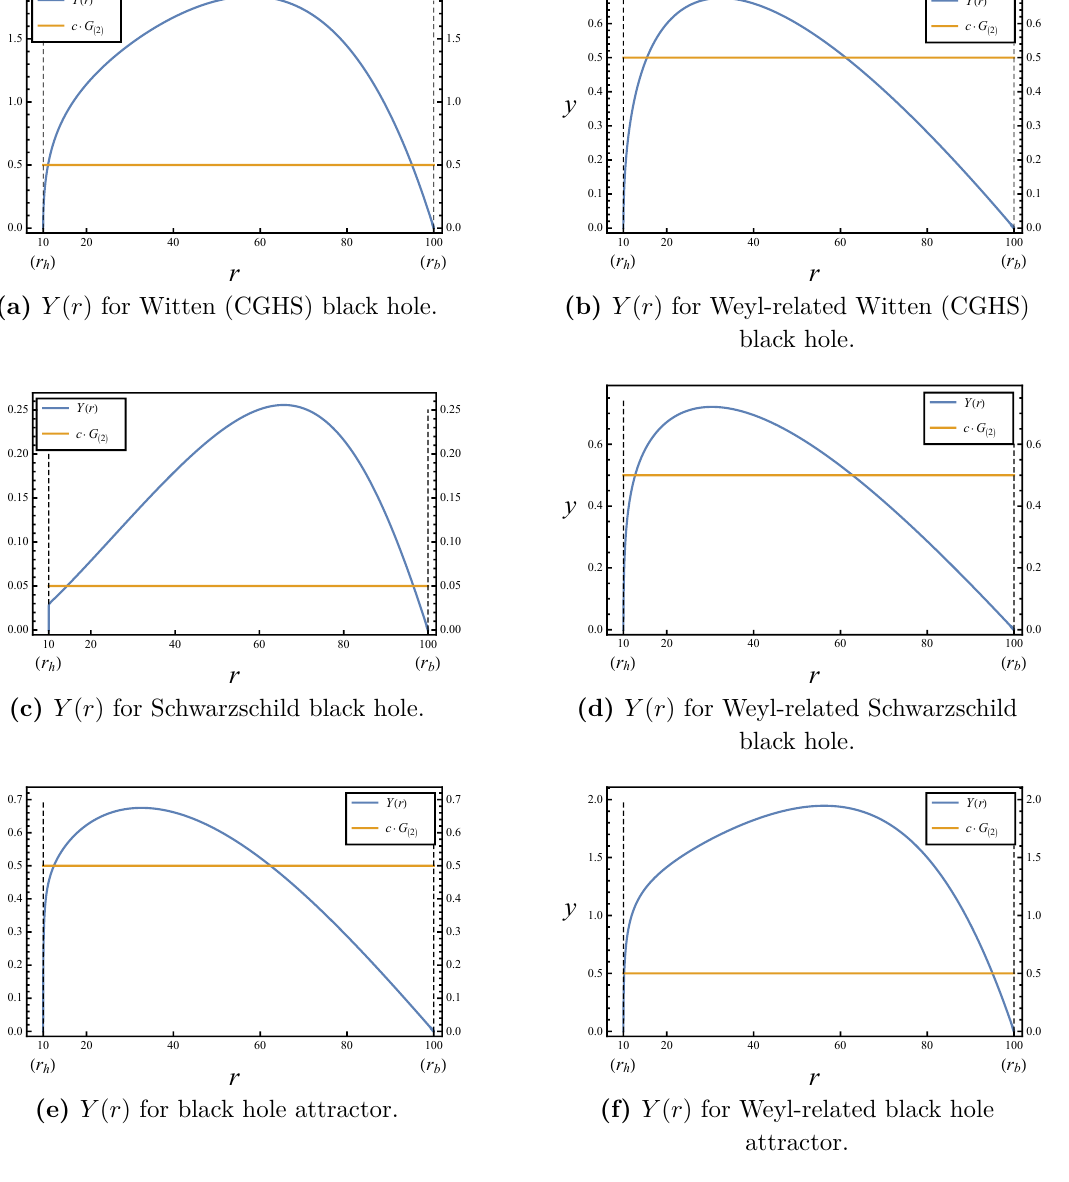
Figure 4. Y -functions (2.16) for (asymptotically) flat black holes. We draw these diagrams by setting r = 10 , λ = 10 − 2 , r = 10 r h b h